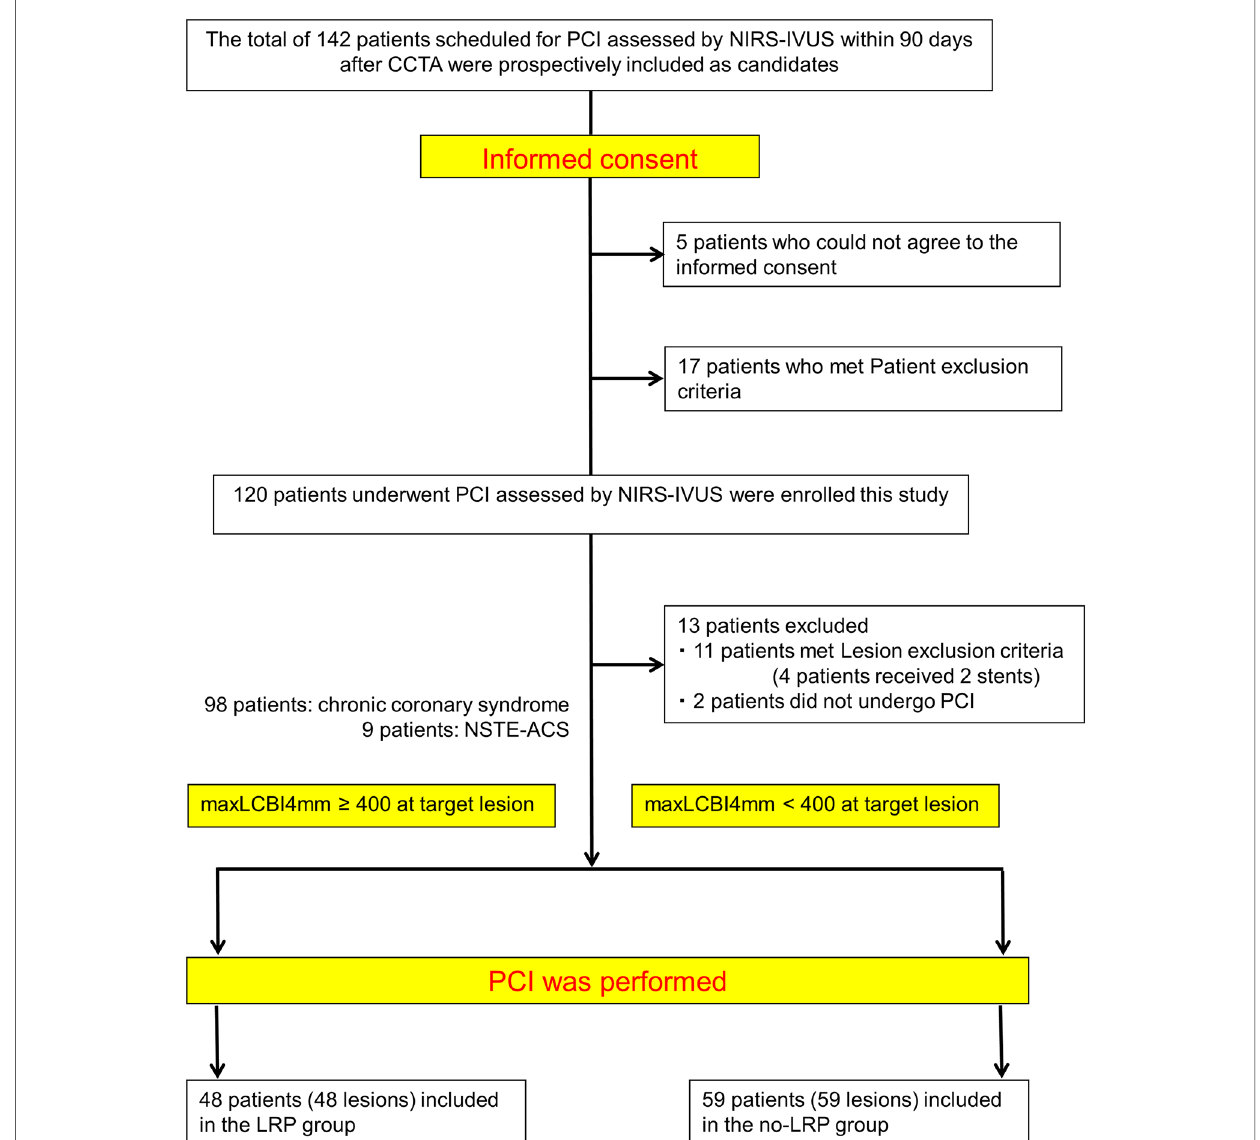
FIGURE 2 Study fl ow chart. PCI, percutaneous coronary intervention; NIRS, near-infrared spectroscopy; IVUS, intravascular ultrasound; CCTA, coronary computed tomography angiography; NSTE-ACS, non – ST-elevation acute coronary syndrome; maxLCBI4mm, maximal lipid core burden index at the 4-mm segment; LRP, lipid-rich